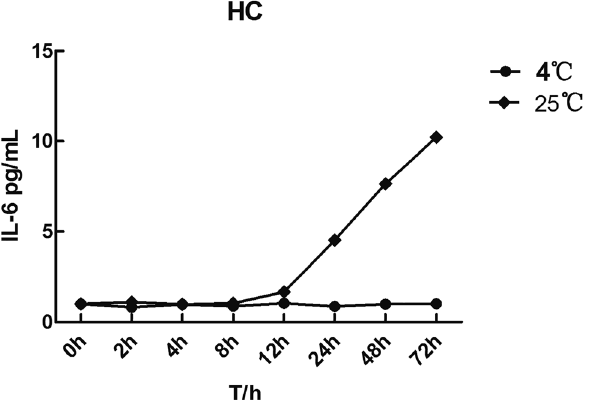
Figure 2: The change of median concentration of IL-6 in healthy patients stored at 4 ° C and 25 ° C.